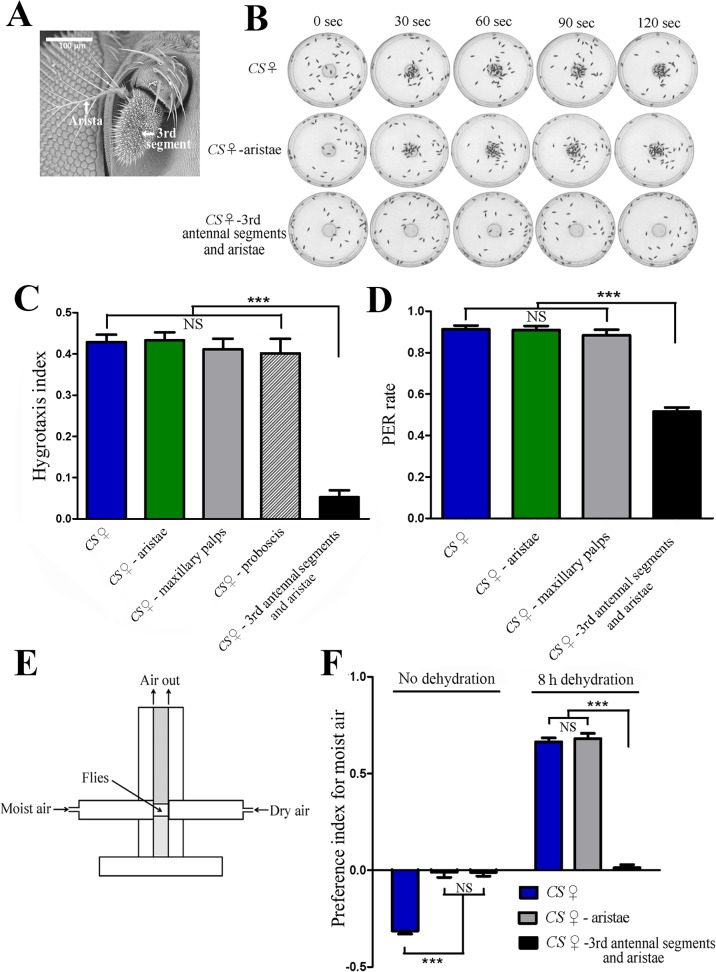
Third antennal segments are required for hygrotactic behavior.(A) Scanning electron microscope photograph showing the third antennal segment and arista of Drosophila. (B) The hygrotactic behavior was tested in wild type flies and the wild type flies that had removed aristae or both third antennal segments and aristae. Ablation of the third antennal segments and aristae abolished hygrotactic behavior, while removing the aristae alone did not affect hygrotactic behavior. All tested flies were dehydrated for 8 hours. (C) Ablation of the third antennal segments and aristae greatly reduced the hygrotaxis index in wild type flies dehydrated for 8 hours. N = 12. (D) Ablation of the third antennal segments and aristae significantly reduced moisture-induced PER rate in wild type flies dehydrated for 8 hours, while removing the aristae alone did not affect the PER rate. N = 8 trials with 50 flies per trial per condition. (E) Schematic diagram of the T-maze apparatus used in the humidity choice assay. Two tubes in the apparatus were filled with moist air (~99% RH) and dry air (~3% RH), respectively. Flies were placed between the two tubes, and allowed to make a choice between the two types of air. (F) The effect of sensory organ ablation on humidity choice behavior in wild type flies. Before dehydration, the intact wild type flies avoid moist air, while the wild type flies with the ablation of aristae or both the third antennal segments and aristae showed no bias towards dry or moist air. After dehydration for 8 hours, the intact flies and flies with aristae removed exhibited a strong preference for moist air, while flies with both third antennal segments and aristae removed showed no humidity preference. N = 15. NS, not significant (p > 0.05); ***, p < 0.001 (ANOVA with Tukey post hoc test). Data are presented as mean ± SEM.